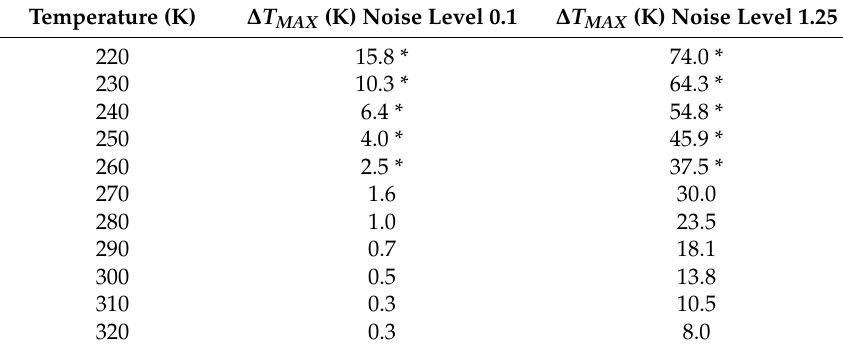
Table 1. Example of maximum allowed temperature differences ( ∆ T ) after Median filtering for two different noise level categories and as a function of some selected scene temperatures (column 1). Notice that the applied method uses a finer temperature resolution of the tabulated values than presented here. Temperature (K) ∆ T MAX (K) Noise Level 0.1 ∆ T MAX (K) Noise Level 1.25 220 15.8 * 74.0 * 230 10.3 *